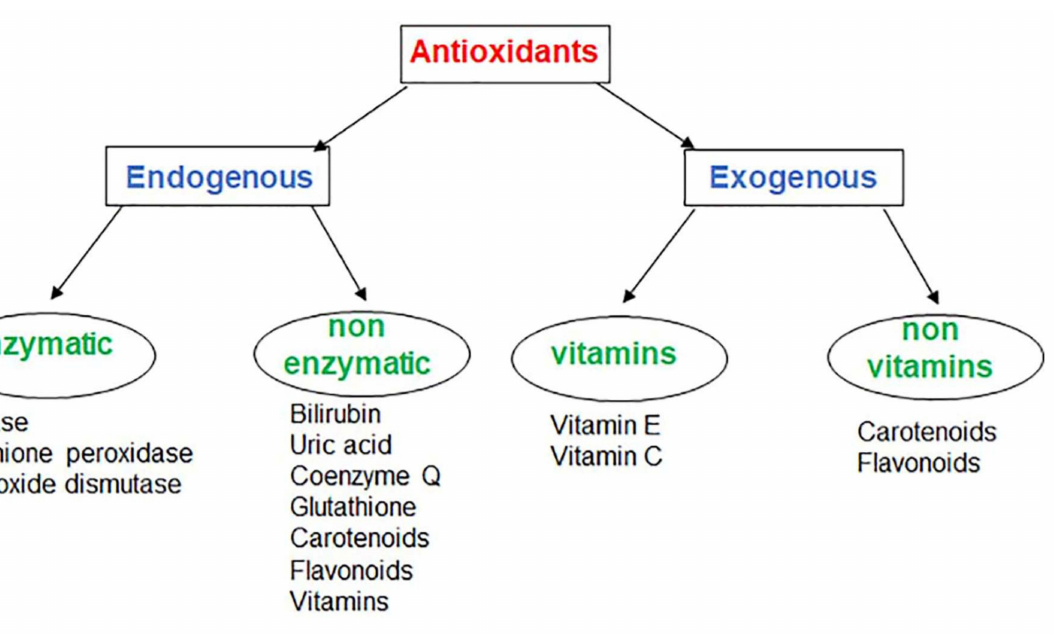
Figure 1. Classification of